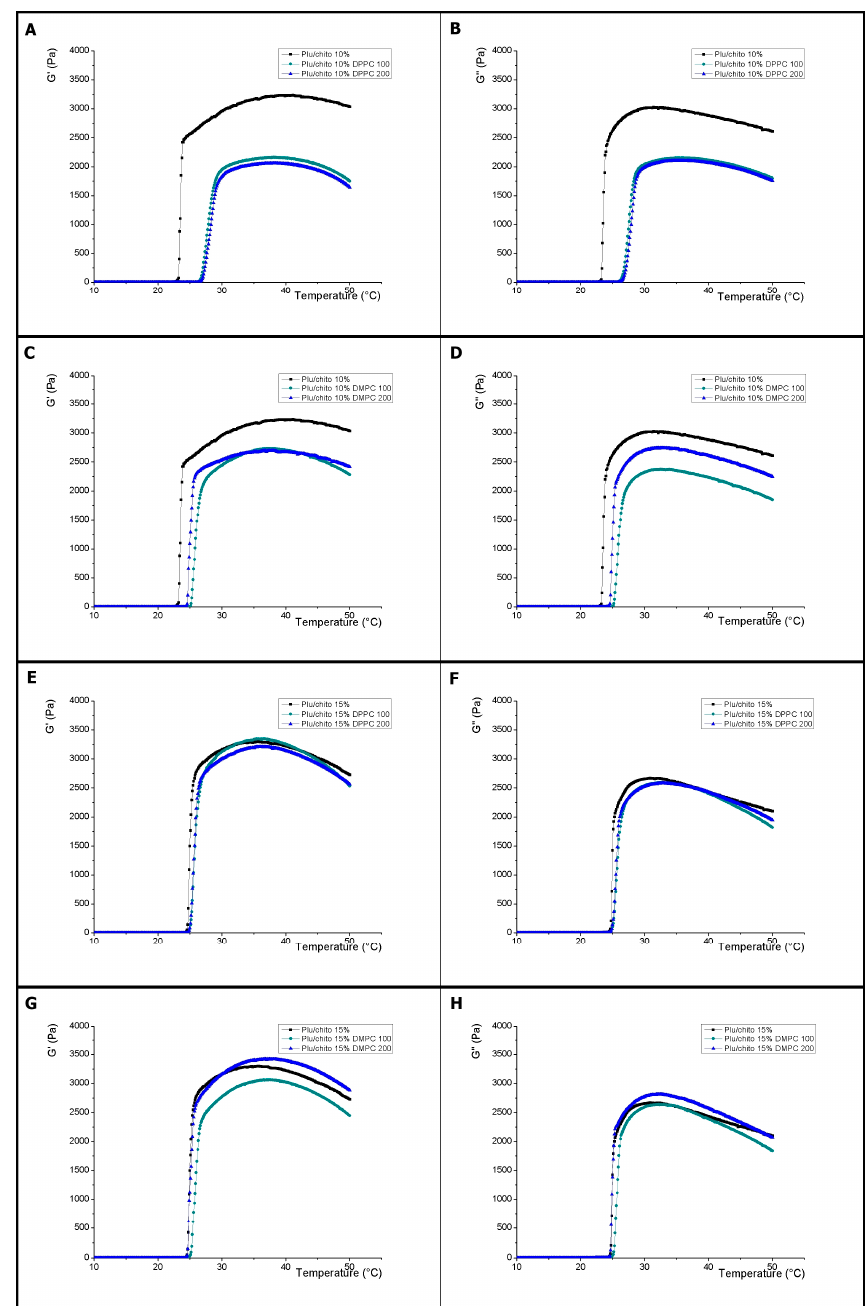
Figure 2. Variation of elastic ( G ′ ) and viscous ( G ′′ ) modules as a function of temperature. ( A , B ) correspond to the effect of incorporation of DPPC composed liposomes built by extrusion with membranes of 100 and 200 nm (pluronic 10% DPPC 100 and pluronic 10% DPPC 200, respectively) on Pluronic F127/Pluronic F127-Chitosan 10% hydrogels; ( C , D ) correspond to the effect of incorporation of DMPC composed liposomes built by extrusion with membranes of 100 and 200 nm (pluronic 10% DMPC 100 and pluronic 10% DMPC 200, respectively) on Pluronic F127/Pluronic F127-Chitosan 15% hydrogels; ( E , F ) correspond to the effect of incorporation of DPPC composed liposomes built by extrusion with membranes of 100 and 200 nm (pluronic 15% DPPC 100 and pluronic 15% DPPC 200, respectively) on Pluronic F127/Pluronic F127-Chitosan 15% hydrogels; ( G , H ) correspond to the effect of incorporation of DMPC composed liposomes built by extrusion with membranes of 100 and 200 nm (pluronic 15% DMPC 100 and pluronic 15% DMPC 200, respectively) on Pluronic F127/Pluronic F127-Chitosan 15% hydrogels.